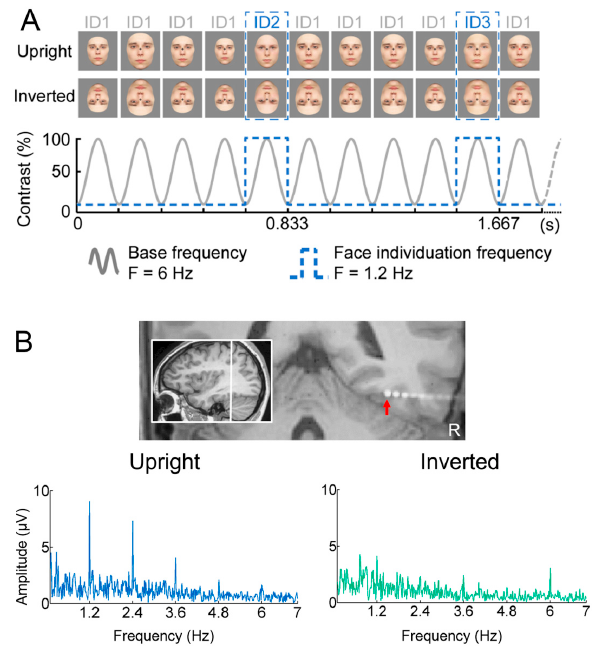
Figure 16. ( A ) The basic FPVS paradigm to measure (unfamiliar) face identity recognition (as published originally by [184]). The same face identity (ID1) is repeated at 6 Hz (across substantial changes of size or other low-level characteristics), interrupted every five stimuli (i.e., at 1.2 Hz) by different face identities (ID2, ID3, . . . ). Inversion—preserving all physical feature differences between the stimuli—generally acts as an additional control to isolate the contribution of our experienced- based structural memory of faces to the recognition function. ( B ) SEEG frequency-domain responses recorded at an individual intracerebral recording contact in the upright (left) and inverted (right) conditions depicted above, with much larger responses to upright faces. The anatomical location of the contact (in the right latFG) is shown in a coronal MRI slice (indicated by a red